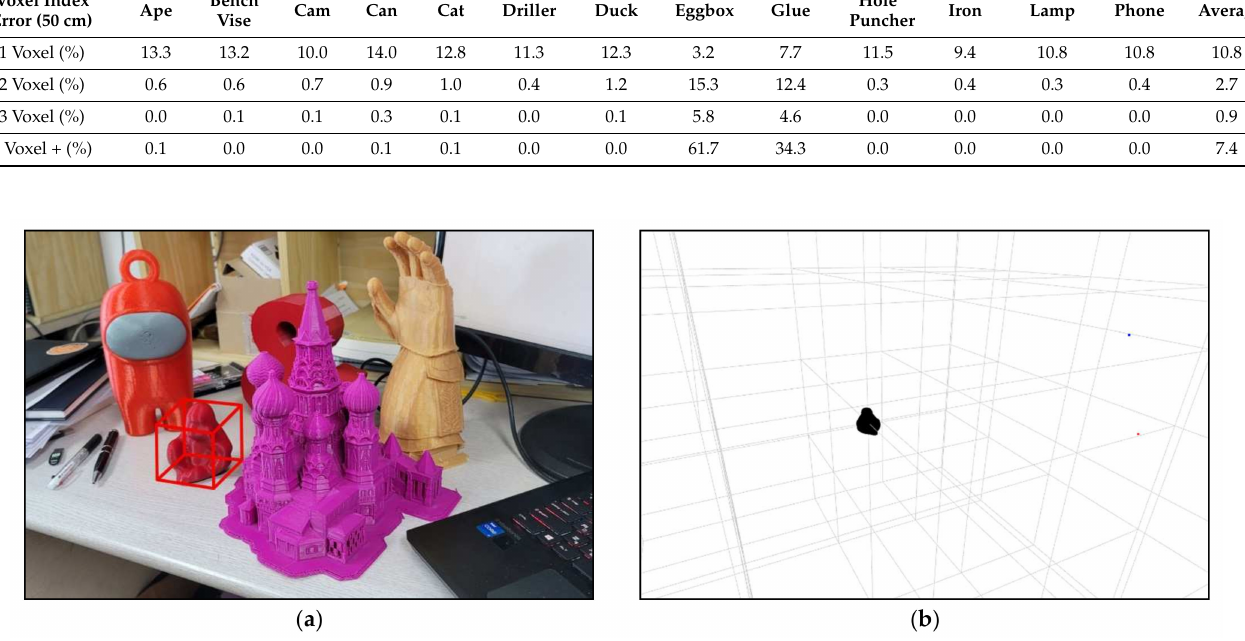
Figure 6. Results on the LineMOD dataset: ( a ) the input RGB images, poses estimated with the extended single-shot deep CNN in blue, and ground truth poses in red; ( b ) visual positioning system in voxel database with voxel labeling